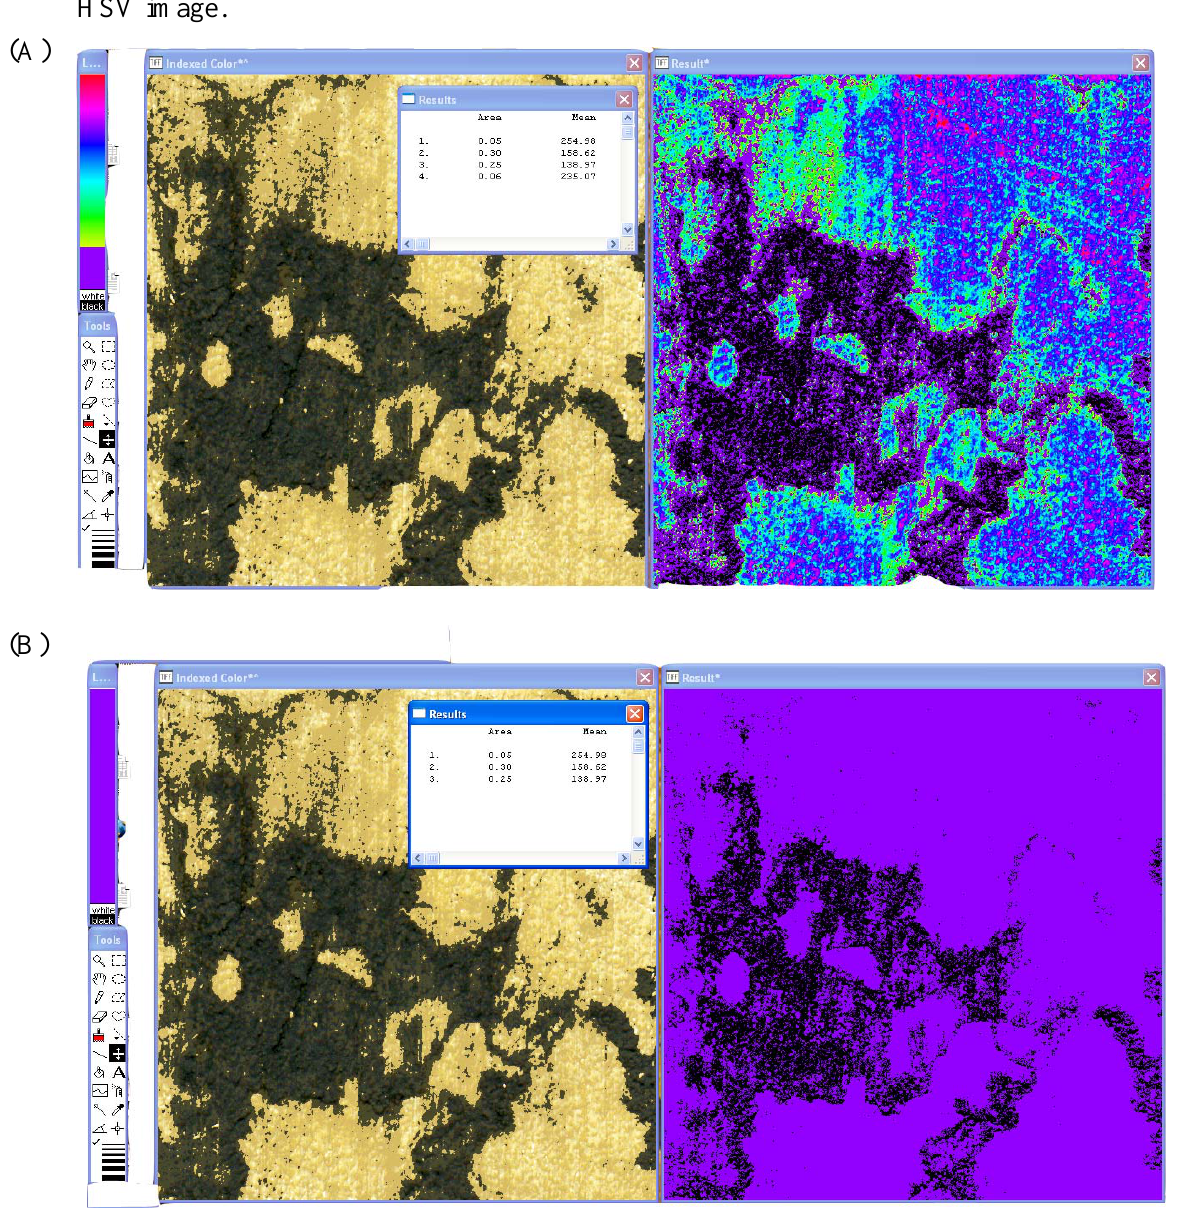
Figure 2 . Color analysis of spalted wood using the LUT tool. (A): Analysis of zone line pigments except true black from the HSV image. (B): Total area measurement of the HSV